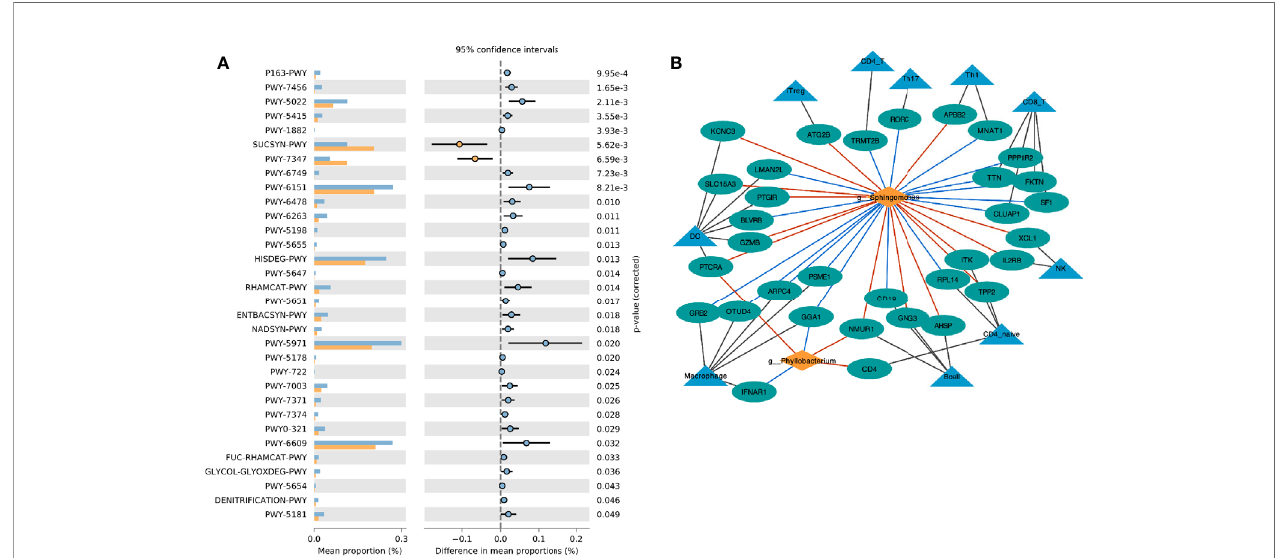
FIGURE 4 | Interaction between endometrial immune cell and microbiota. (A) Comparison of differences in metabolic pathway between CE and non-CE group; (B) Network visualizing the relationship between genus, immune cell marker genes and immune cells. The red line indicates the positive correlation (red) or negative (blue) relationship between the genera and the gene.